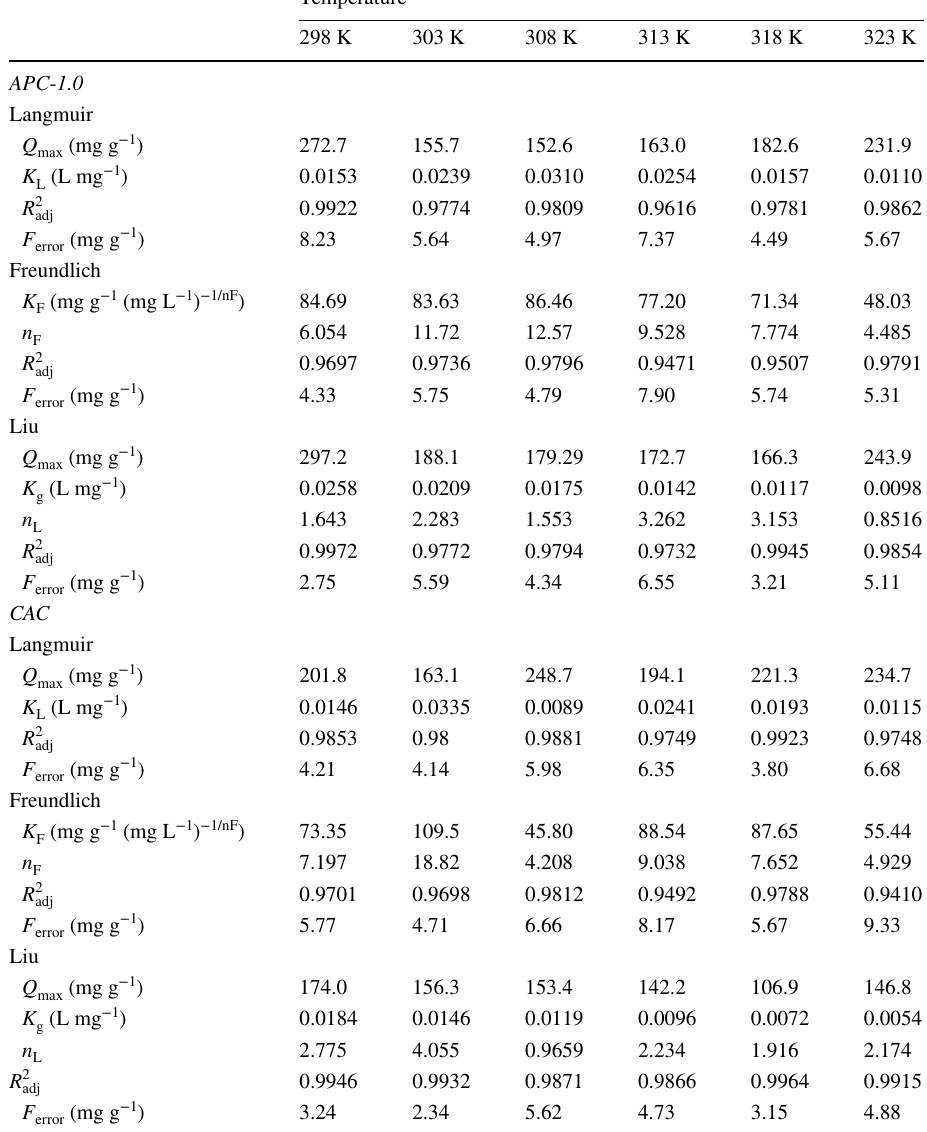
Table 3 Isotherm parameters for PR-5B dye adsorption using APC-1.0 and